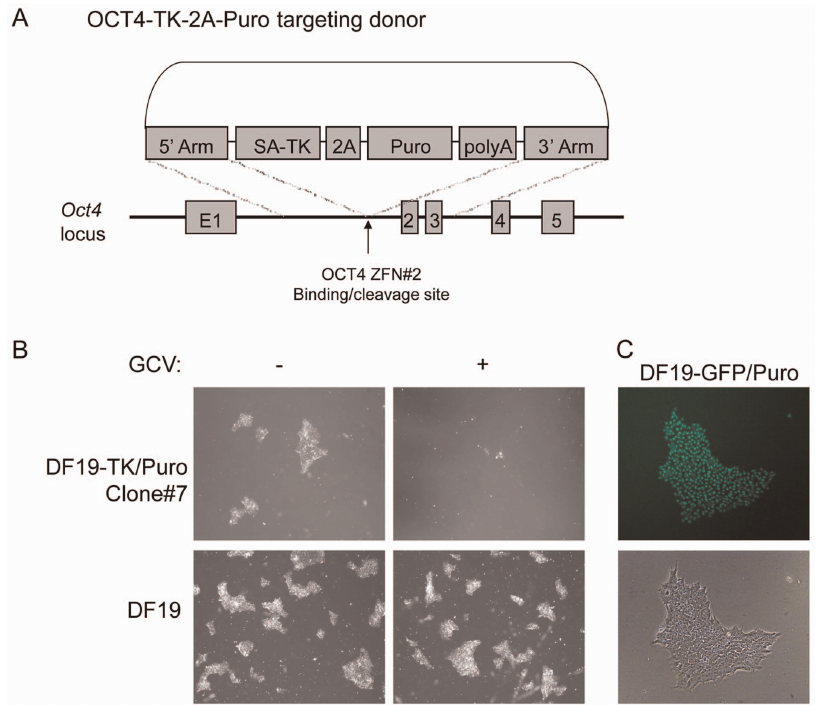
Figure 3. Test of ZFN targeting strategy in DF19 cells. A. Overview depicting the targeting strategy for the OCT4 locus. B. Panels displaying one of the puromycin-resistant cell clones (DF19-TK/Puro Clone # 7) and unmodified DF19 cells after treatment with or without 2 m M GCV for 2 days. Bright field pictures were taken using a 2 6 objective. C. Panels showing one of the clones (DF19-GFP/Puro) obtained using the OCT4-eGFP-2A-Puro control plasmid.